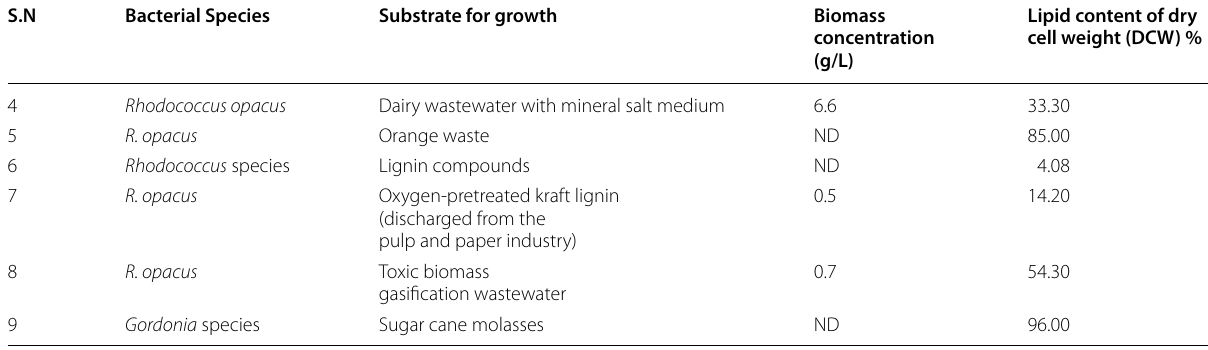
Table 3 List of various substrates for growth of bacteria and their lipid content (Kumar et al. 2015; Kumar et al. 2017a, b; Goswami et